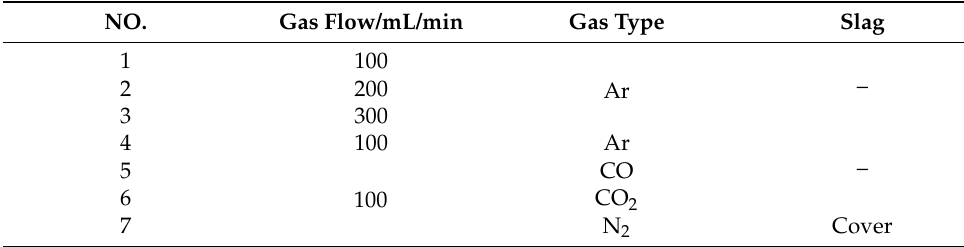
Table 3. Experimental plan for oxygen blowing decarburization period.